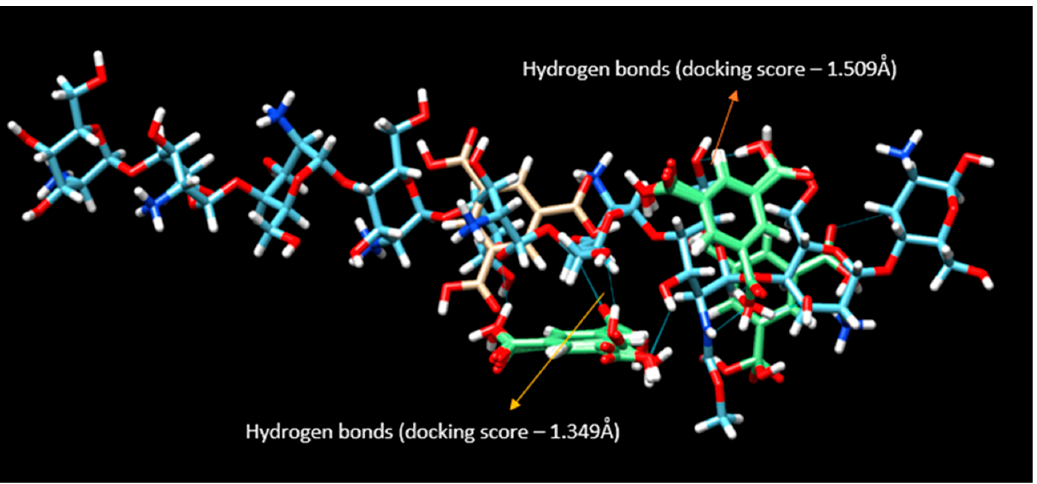
Figure 6. Chimera model. The binding energy of two different torsions (one having a score of − 3.4 and another − 3.3) are presented in this picture. The two green portions show possible binding of the polymer with BTC.